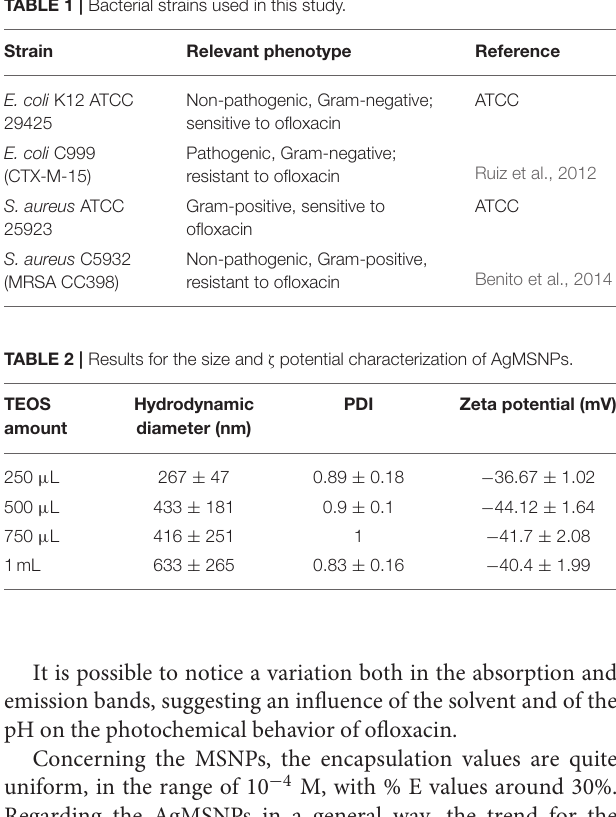
TABLE 1 | Bacterial strains used in this study.